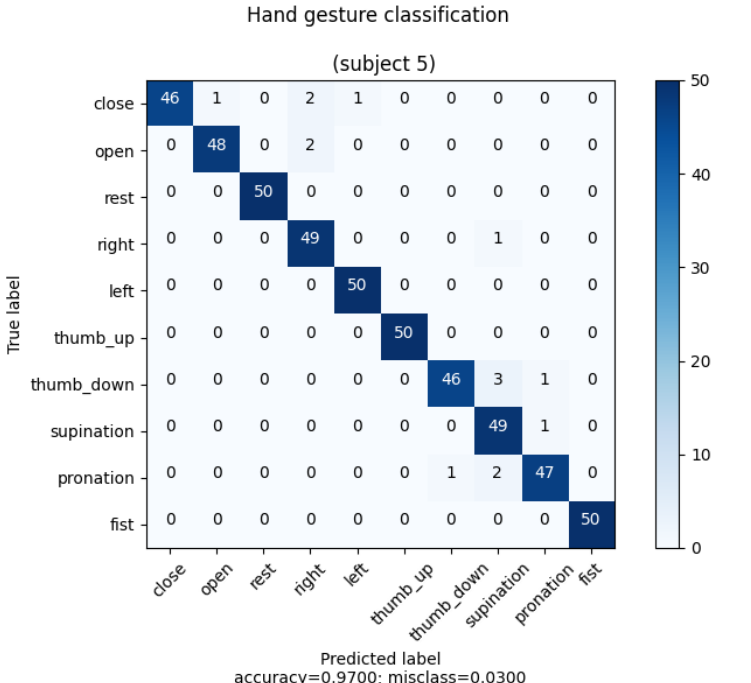
Figure A5. Confusion matrix of a subject who participated in data collection (subject 5).